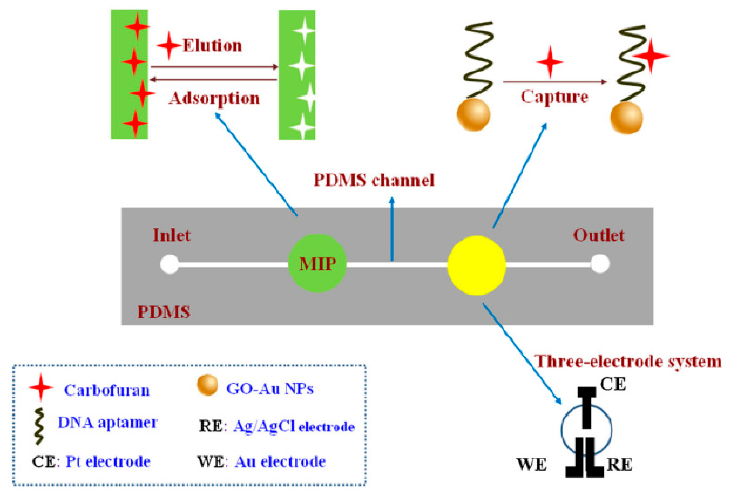
Figure 6. Fabrication of MIP–aptamer microfluidic chip for the detection of carbofuran. Reproduced with permission from [49]. Copyright Springer, 2018.